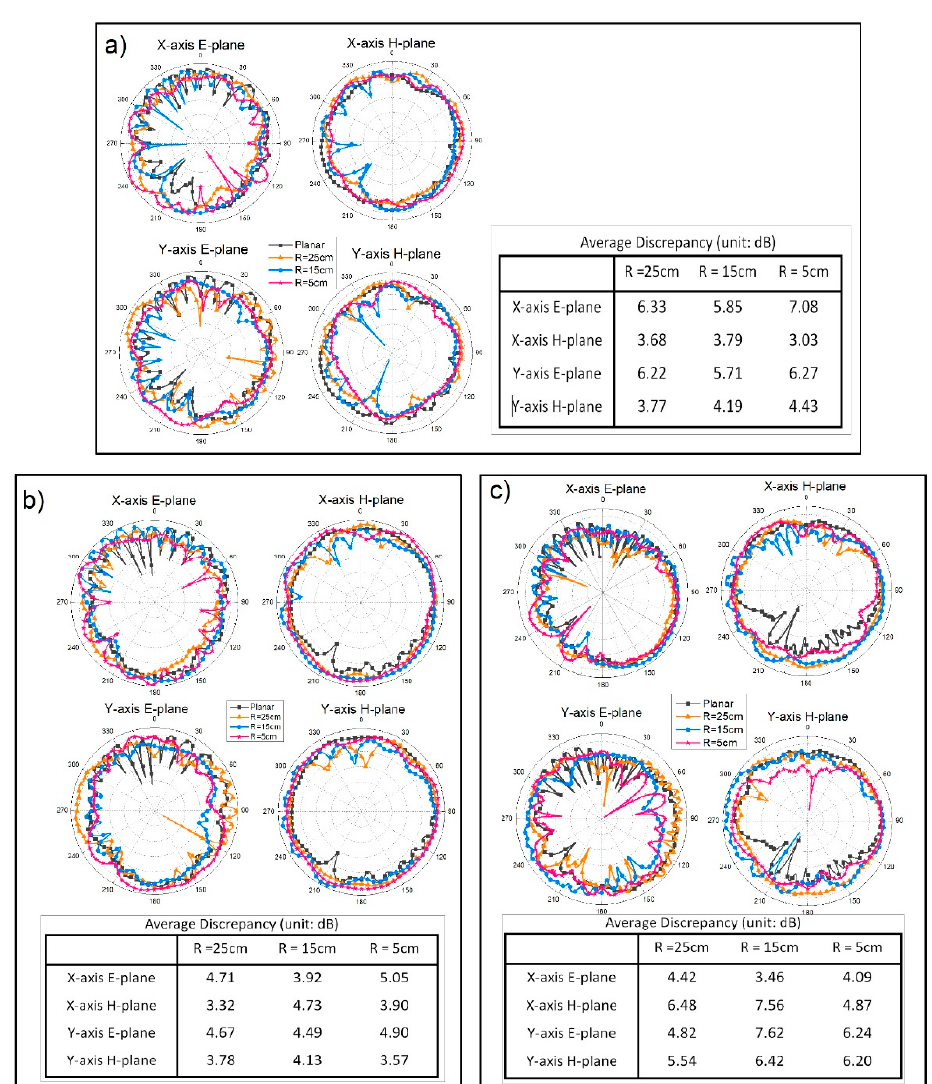
Figure 8. The radiation patterns of the proposed antenna under bending along the X -axis and the Y -axis, and the corresponding average discrepancies at ( a ) 4 GHz; ( b ) 5 GHz; and ( c ) 8 GHz.